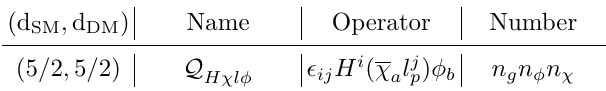
Table 14 . Dimension-five ∆ B = 0 , ∆ L = 1 operator in DSMEFT. The first column gives the dimensions of the SM and DM part of the operator, and the fourth column is the number of